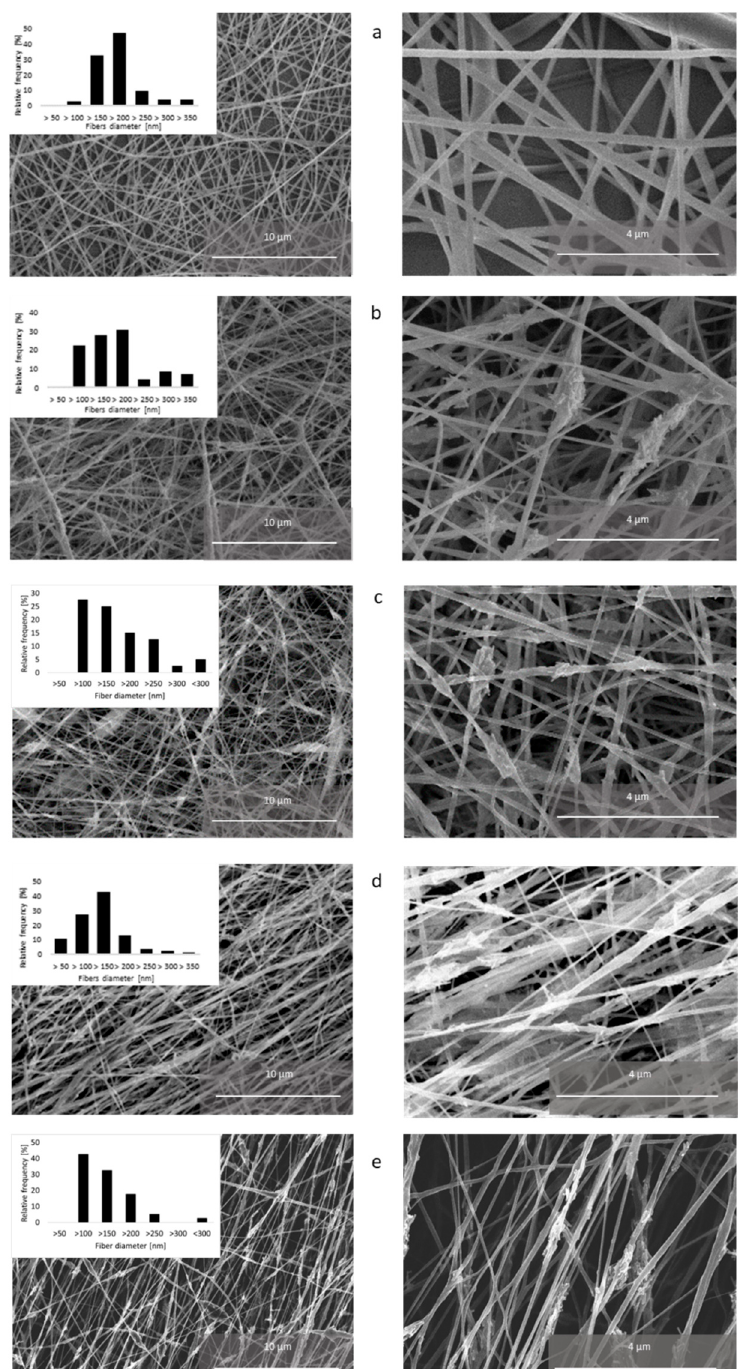
Figure 5. Electrospun fibers ( a ) PCL-2 (random polycaprolactone fibers), ( b ) PCL/HA-2 (random composite fibers), ( c ) PCL/HA-3 (random composite fibers after plasma treatment), ( d ) PCL/HA-4 (as- spun parallel composite fibers), and ( e ) PCL/HA-5 (parallel composite fibers after plasma treatment).